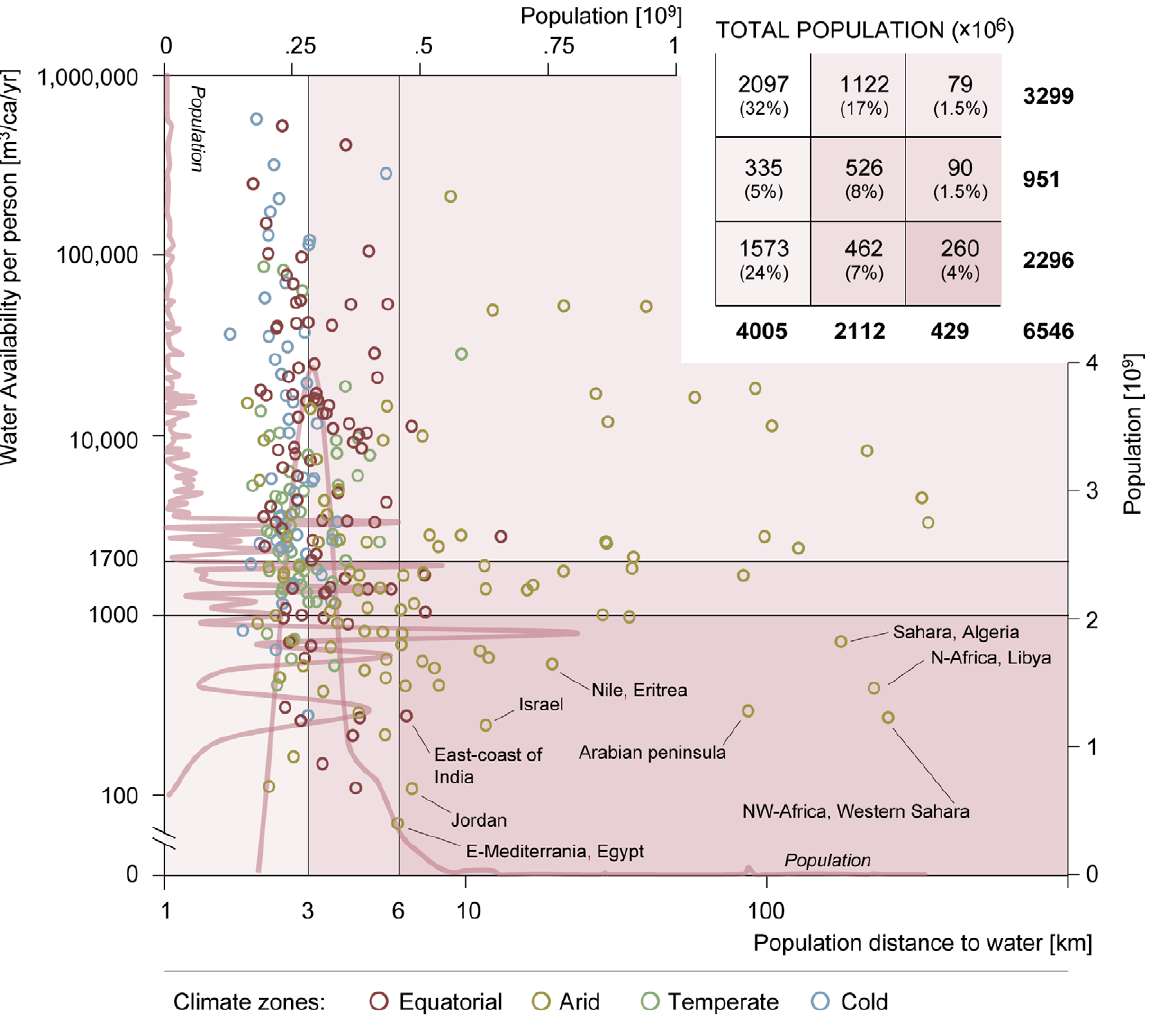
Figure 6. Scatter plot of population distance to water and water availability per person. Analysis scale is the FPU level. Total population in the matrix’s nine areas is presented in the top right corner of the plot, the percentage of the world’s total population is in brackets. The lines represent population distributions for the distance to water (lower x-axis, right y-axis) and for water availability (left y-axis and upper x-axis). These lines represent where large concentrations of people are present. Note: the left and lower axes have a logarithmic scale.